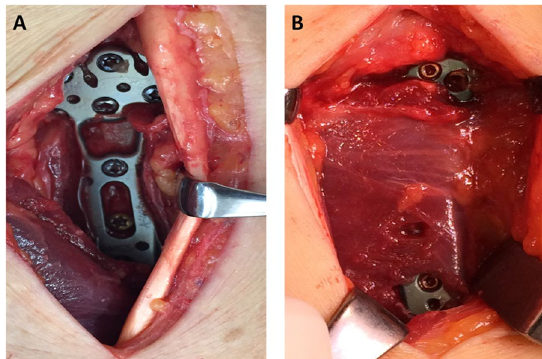
Fig. 2 Intraoperative photographs of two approaches for treating distal radius fractures. A Standard volar approach; B pronator quadratus-sparing